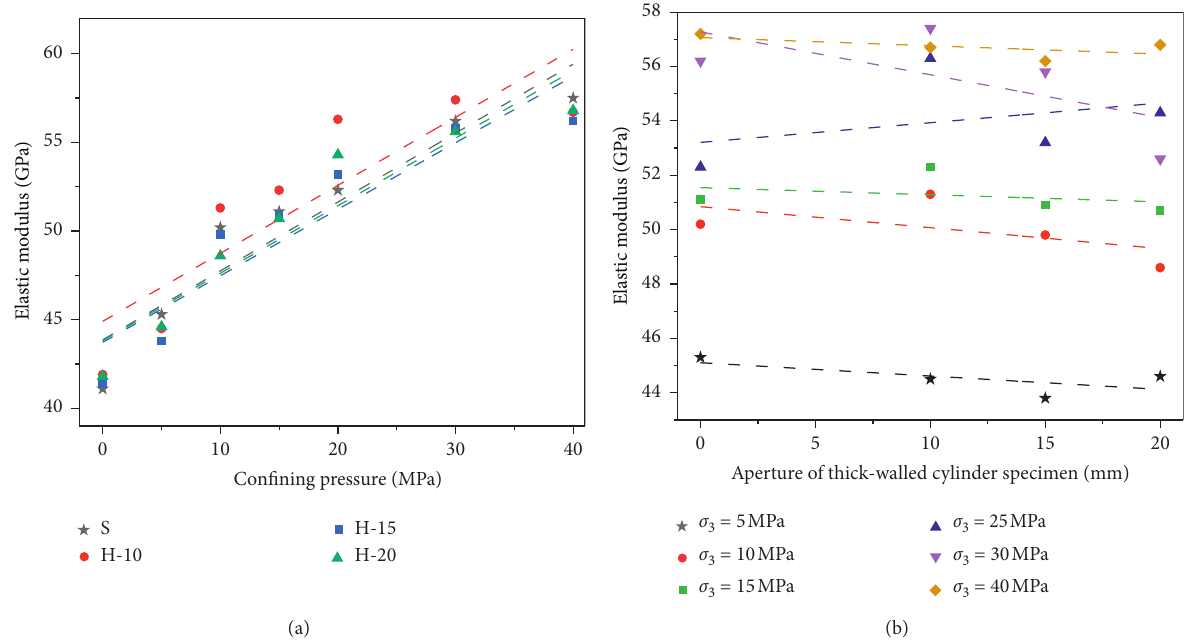
Figure 10: Elastic modulus diagram. (a) Fitting curves between confining pressure and elastic modulus. (b) Fitting curves between apertures and elastic